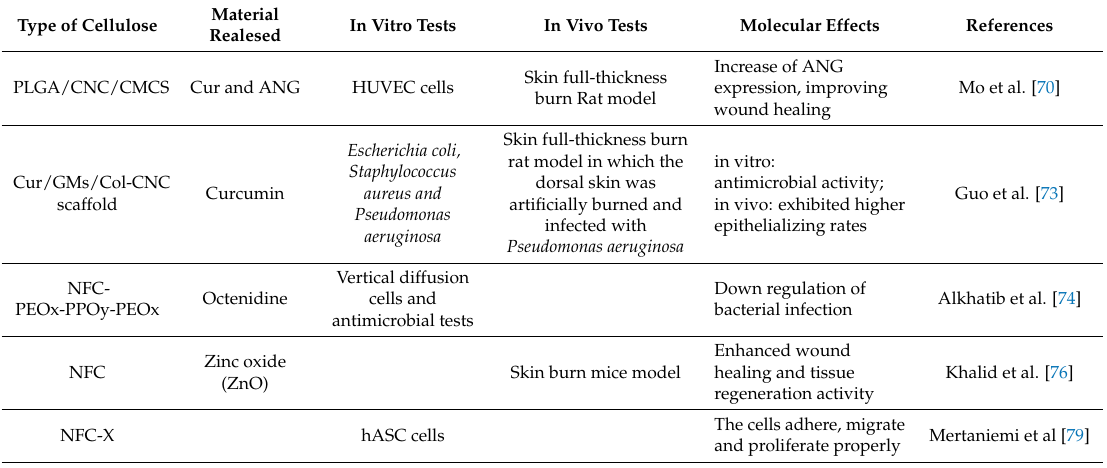
Figure 8. Schematic preparation of nanofibrillar cellulose with glutaraldehyde cross-links (NFC-X) threads and their cross-linking with glutaraldehyde for NFC-X threads. Following preparation, NFC-X threads were loaded with human adipose mesenchymal stem cells (hASC); cells could properly, adhere, migrate and proliferate on the NFC-X. Redrawn from ref [79]. Table 2. Summary of the nano cellulose-based materials tested in wound healing.